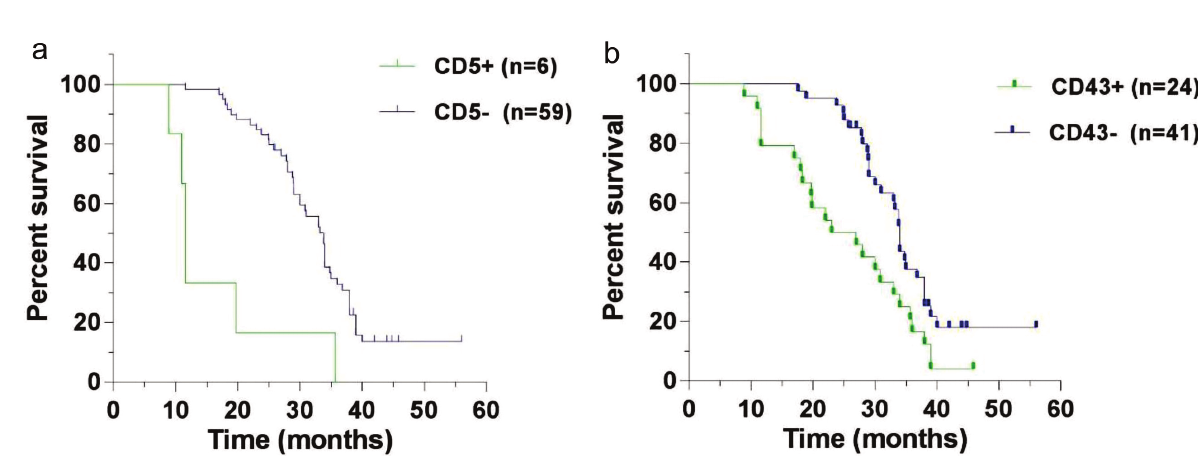
Figure 2: Survival analysis according to the CD5 and CD43 expression in DLBCL patients. a: The MST of CD5 positive DLBCL patients was 11.6 months, and the MST of CD5 negative DLBCL patients was 32.8 months. The difference between the two groups was statistically significant (P=0.001); b: The MST of CD43-positive DLBCL patients was 20.2 months, and the MST of CD43-negative DLBCL patients was 36.4 months. The difference was statistically significant (P=0.003).